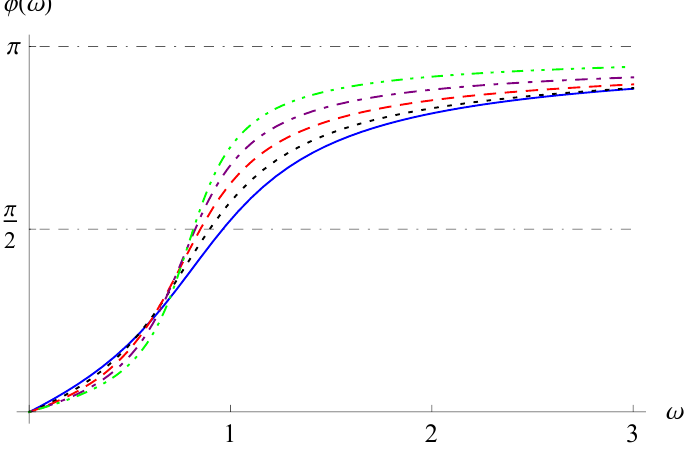
Figure 5. Frequency–phase curves for k = m = 1, c = 0.5, η = 0.5, and λ = 1.1 (solid line), 1.3 (dotted line), 1.5 (dashed line), 1.7 (dot-dashed line), or 1.9 (dot-dot-dashed line).